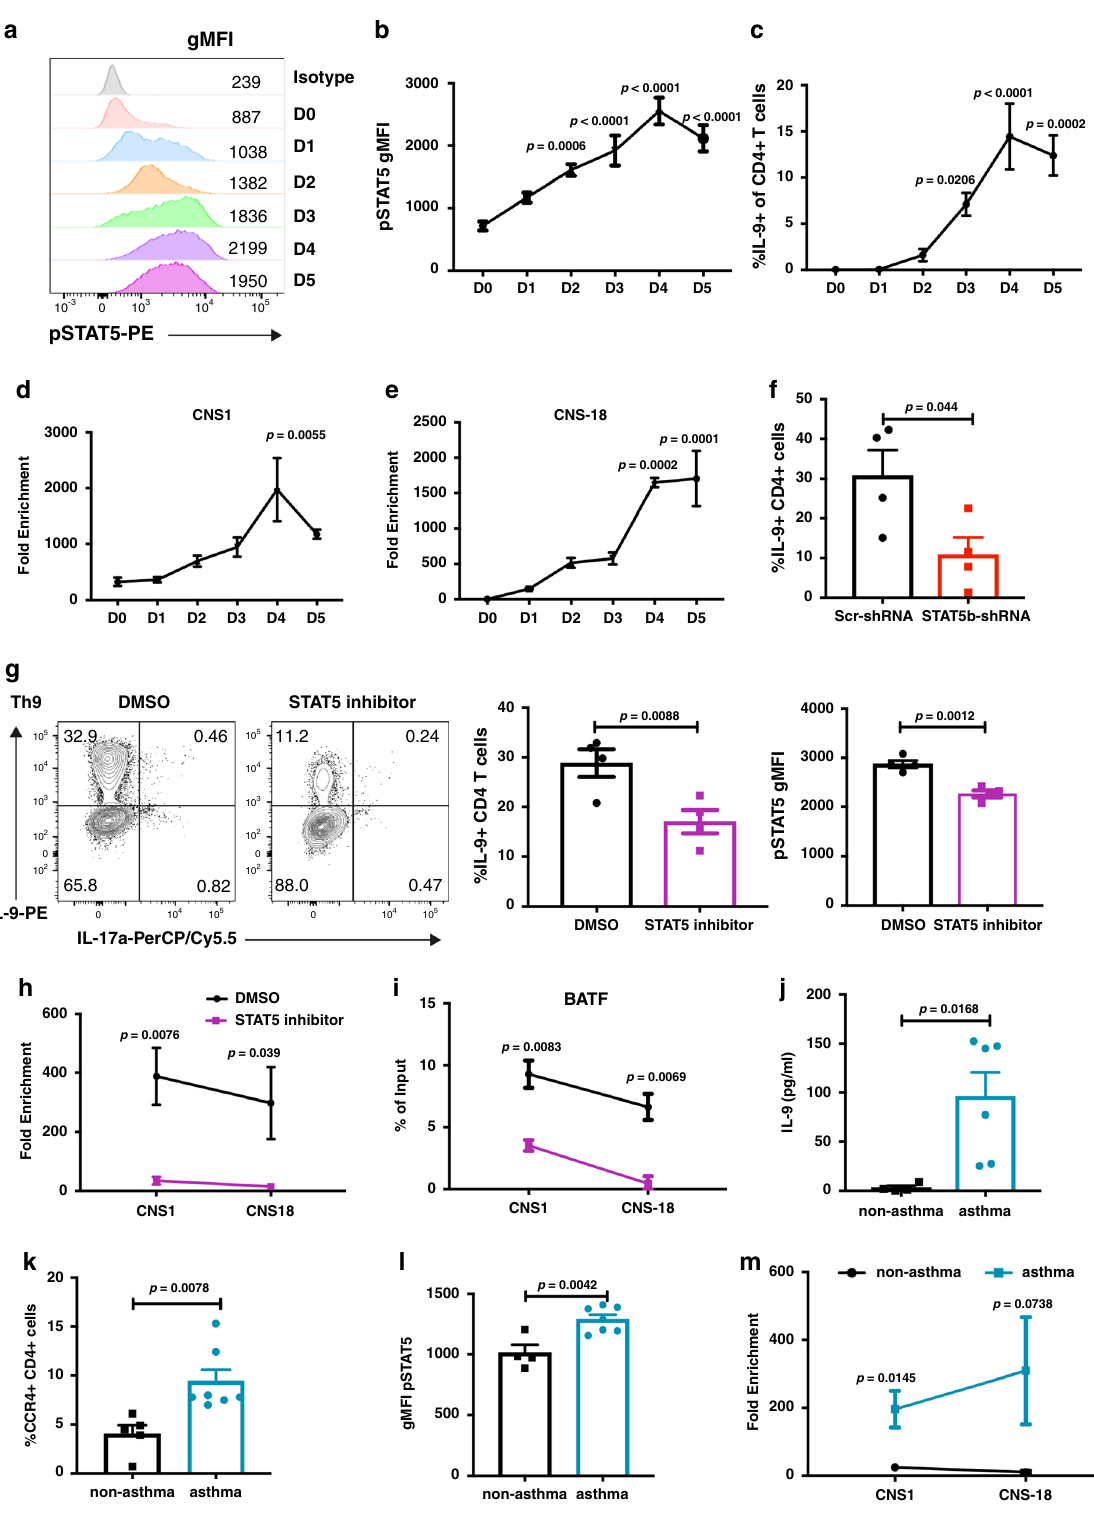
(Fig. 7b). The effects of the combination of caSTAT5 and BATF all groups are not signi fi cantly different (Supplementary Fig. 6a)